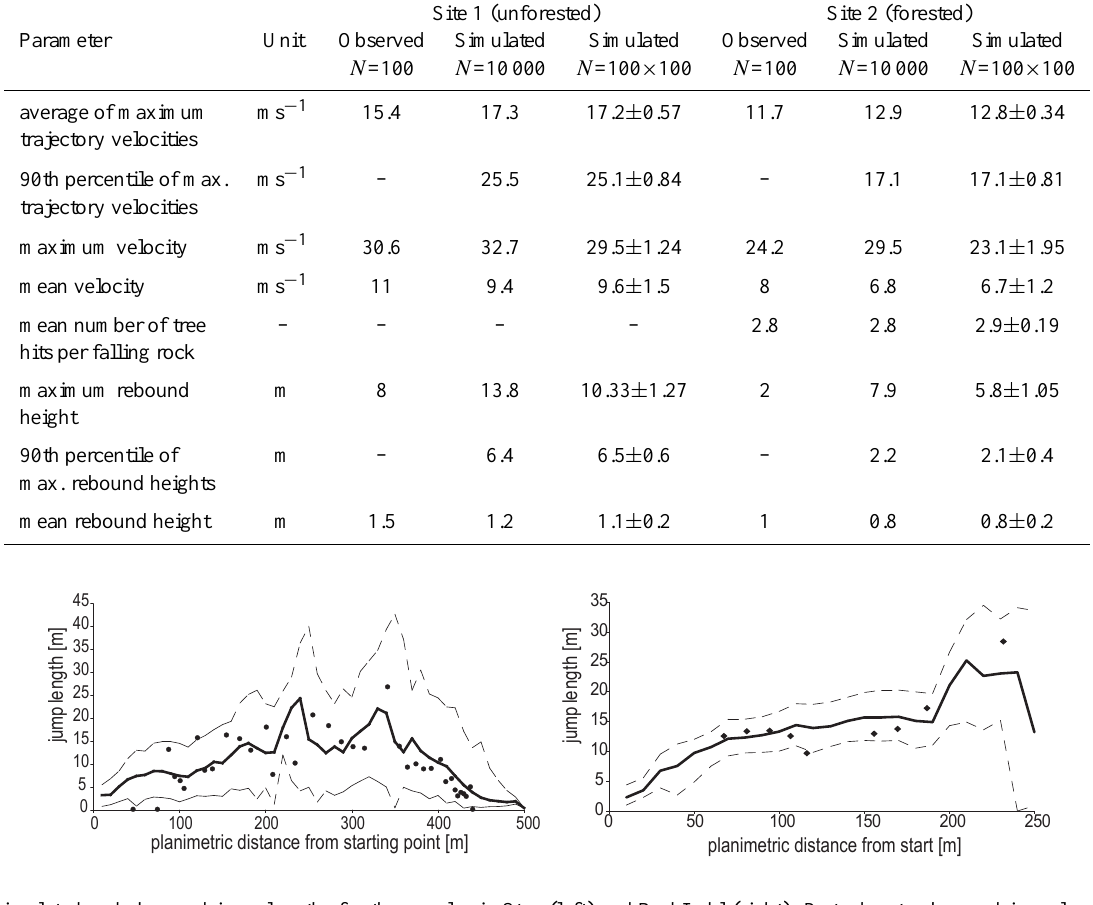
Fig. 9. Simulated and observed jump lengths for the profiles in Steg (left) and Bad Ischl (right). Dots denote observed jump lengths. The bold line indicates mean jump length and the dashed line the minimum and maximum jump length of 10000 simulations.